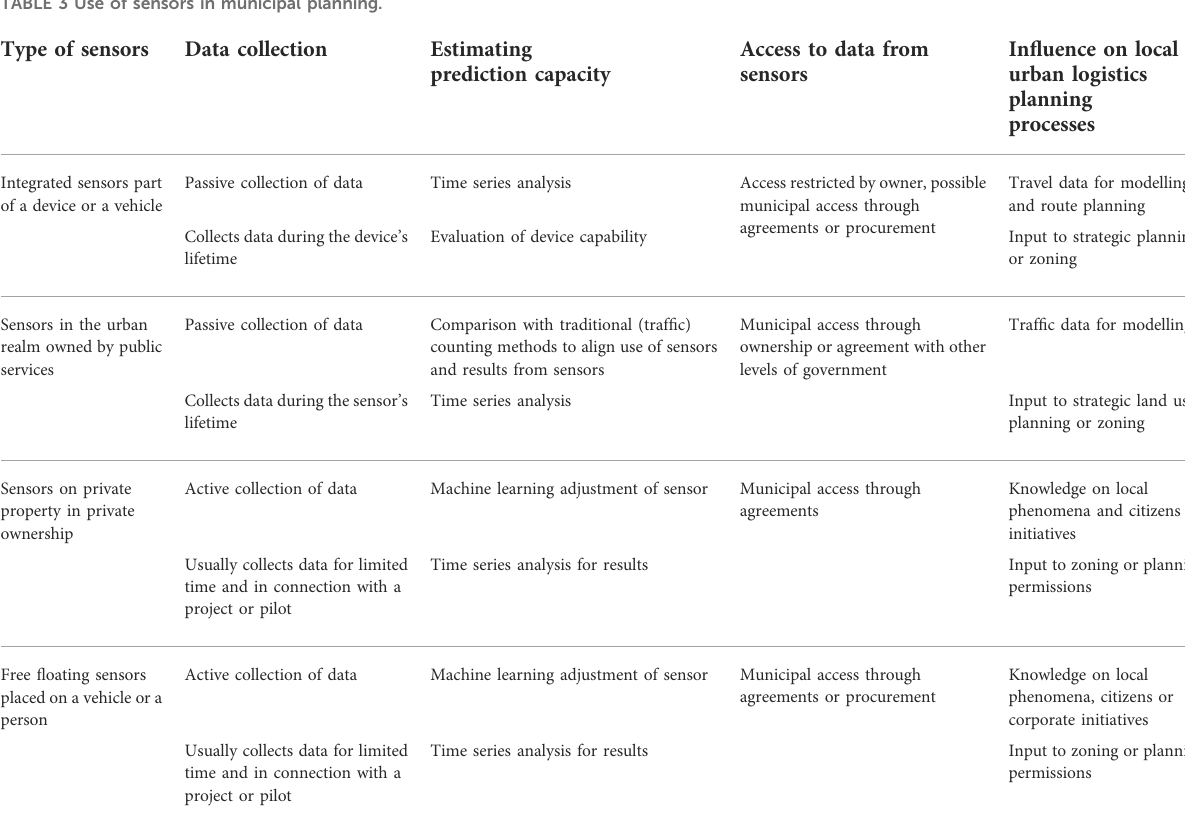
TABLE 3 Use of sensors in municipal